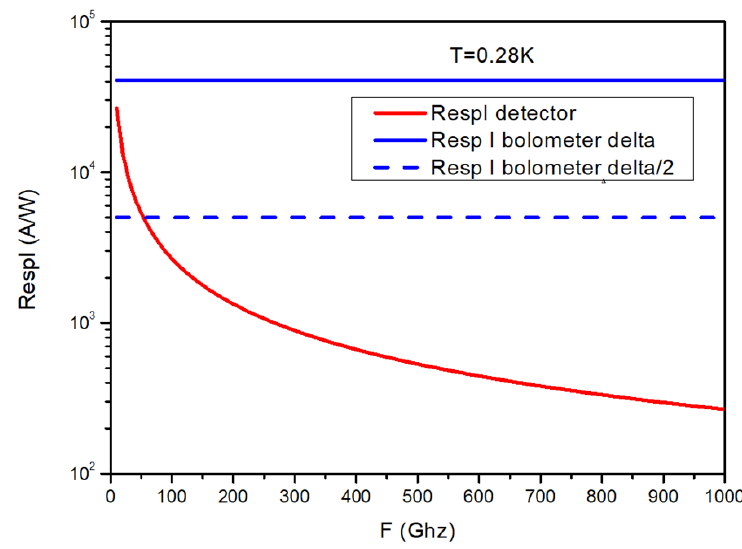
Figure 5. Calculated frequency dependence of current responsivity for the SINIS detector at a bath temperature of 0.28 K. The top blue curve is RespI = e/kT for a bolometer multiplier at a bias voltage close to the energy gap without strong electron cooling; the dashed blue line is the bias at the half gap with RespI = e/2kT, and the red curve is the photon counter, RespI = e/hf in the case of strong electron cooling. Table 1. Current and voltage responsivities for the main SINIS detector operation modes at 350 GHz.